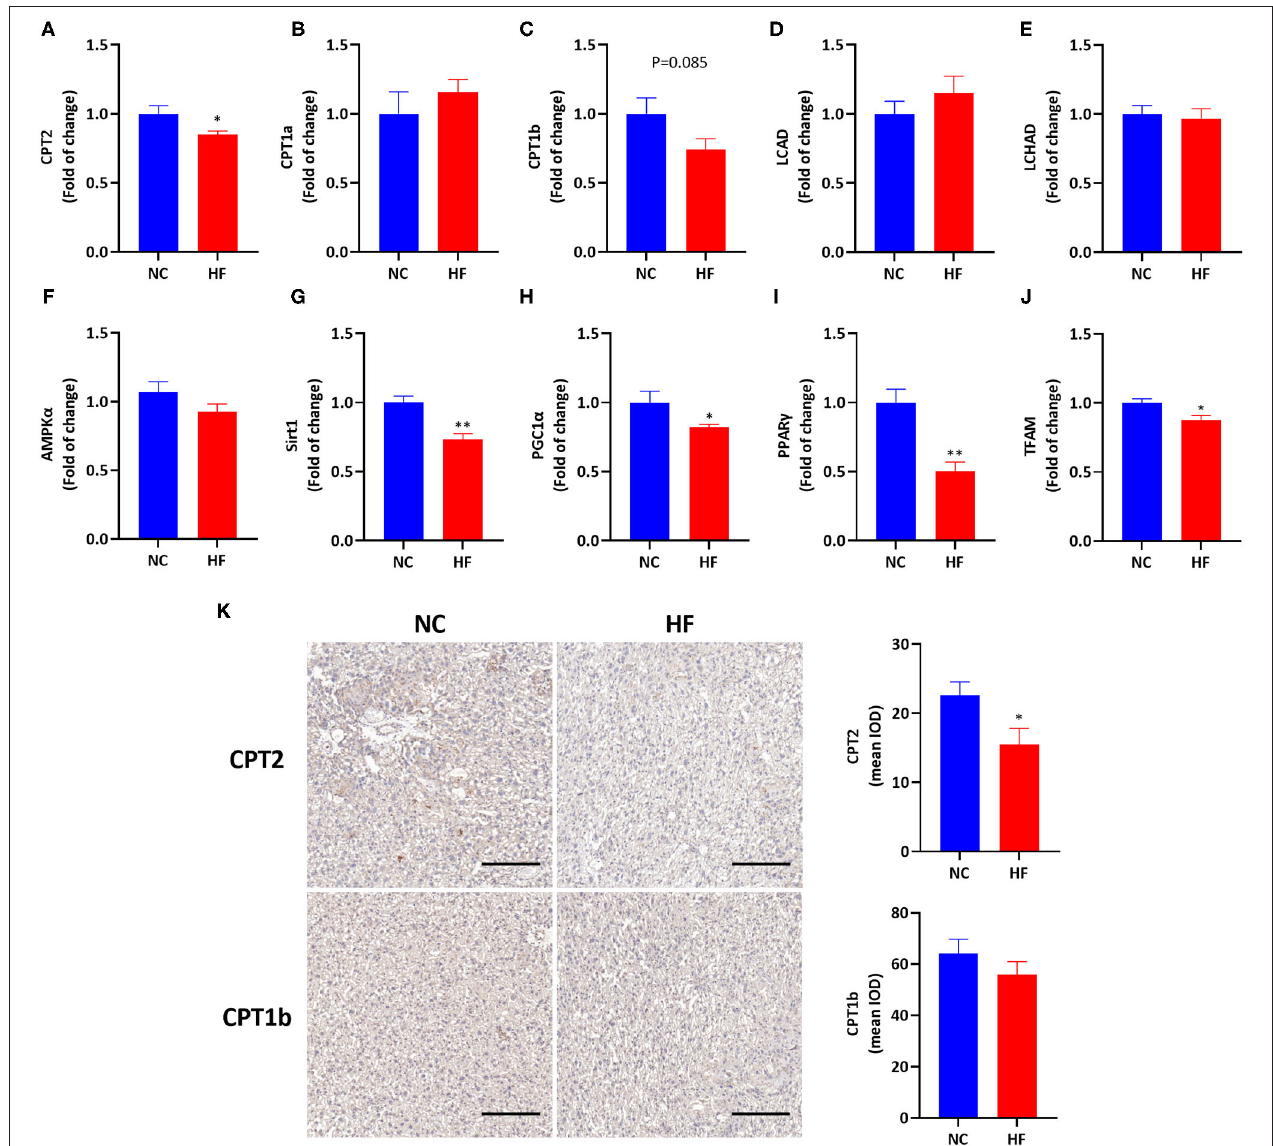
FIGURE 3 | HF feeding reduced placental FAO gene expression by suppressing the AMPK signaling pathway. (A–J) Placental mRNA expression of genes. (A) CPT2; (B) CPT1a; (C) CPT1b; (D) LCAD; (E) LCHAD; (F) AMPK α ; (G) Sirt1; (H) PGC1 α ; (I) PPAR γ ; (J) TFAM; (K) Immunohistological analysis of CPT2 and CPT1b in the placenta, magnification 200x. The scale bar indicates 200 µ m. Data represented as the mean ± SEM. (NC, n = 5–6; HF, n = 7). * p < 0.05, ** p < 0.01, vs. NC. NC, normal chow diet; HF, high-fat diet; CPT2, carnitine palmitoyltransferase 2; CPT1a, carnitine palmitoyltransferase 1a; CPT1b, carnitine palmitoyltransferase 1b; LCAHD, long-chain 3-hydroxyacyl-coa dehydrogenase; LCAD, long chain acyl-CoA dehydrogenase; AMPK α , AMP-activated protein kinase α ; Sirt1, sirtuin 1; PGC1 α , peroxisome proliferator-activated receptor gamma coactivator 1-alpha; PPAR γ , peroxisome proliferator-activated receptor γ ; TFAM, mitochondrial transcription factor A; IOD, integrated optical density.